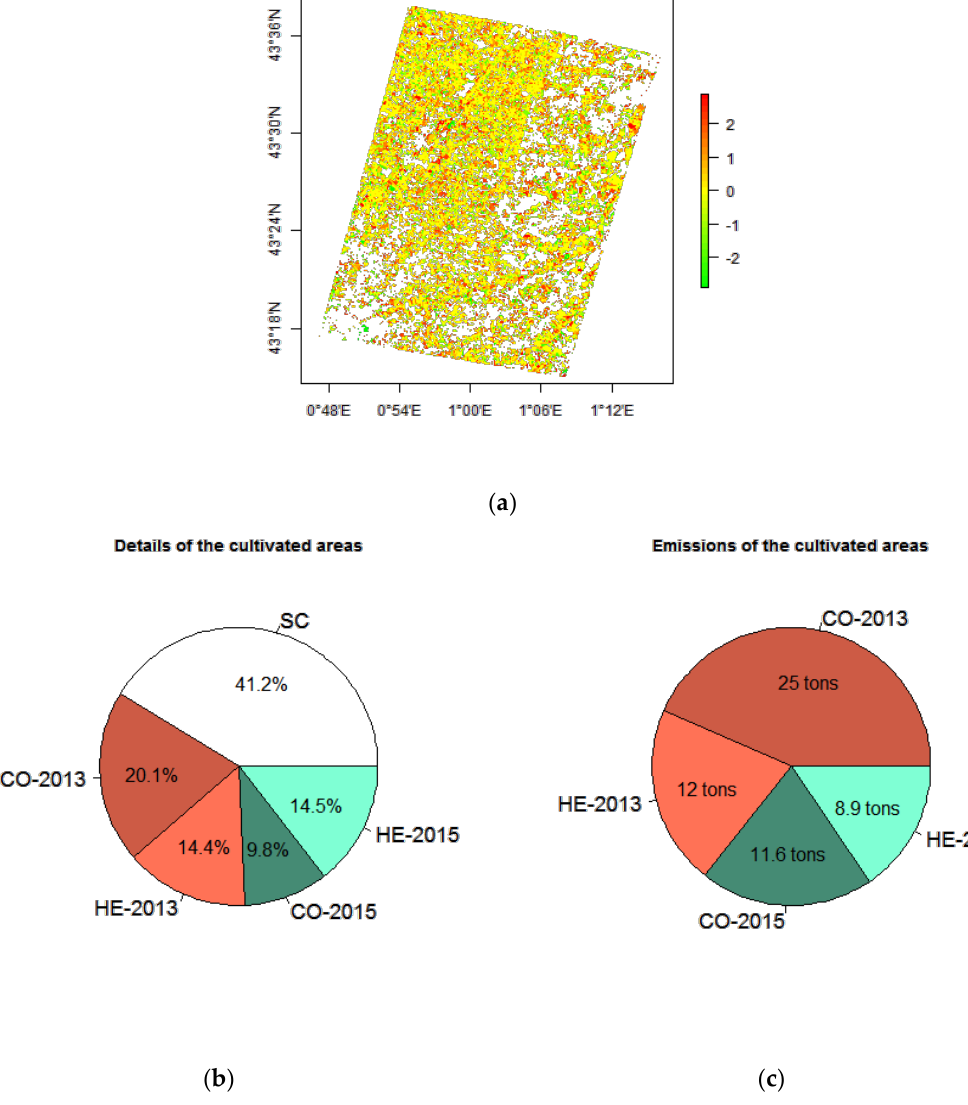
Figure 8. Inter-annual variations of potential N 2 O emissions (in kg of N 2 O) between extreme values emitted for the years 2013 and 2015 ( a ), together with the allocated surfaces ( b ) and cumulative N 2 O emissions ( c ) for the 5 cases, explaining the variations between the two considered years maps (where the abbreviations “SC” “CO” and “HE” correspond to the “Same Crops” cultivated during the two years, “Crops Only” cultivated on a specific year and “Higher Emissions” for the crops cultivated on the specific year).